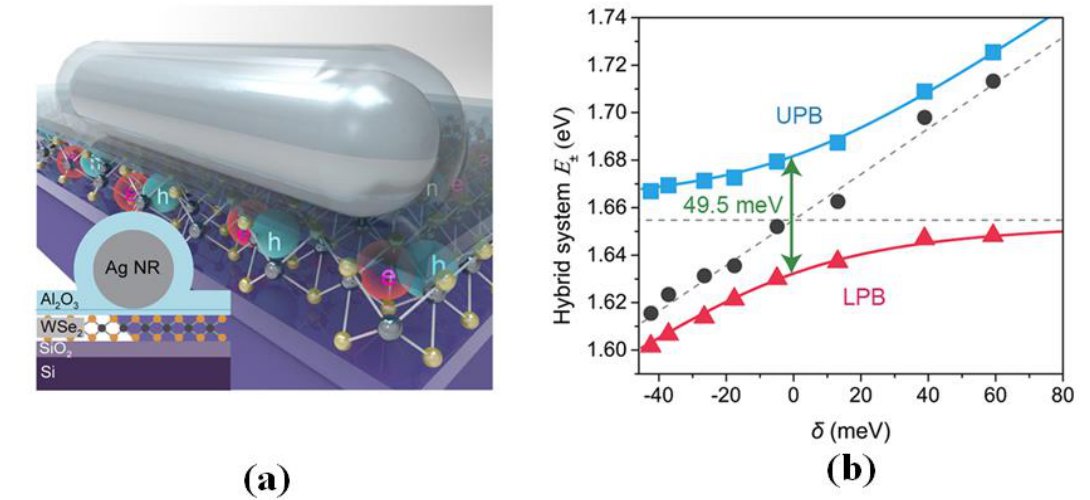
Figure 20. ( a ) Schematic of system with a single silver nanorod on a WSe 2 monolayer. ( b ) Energies of the upper plexciton branch (UPB) (E + , blue square) and the lower plexciton branch(LPB) (E − , magenta triangle) as a function of the detuning [102].